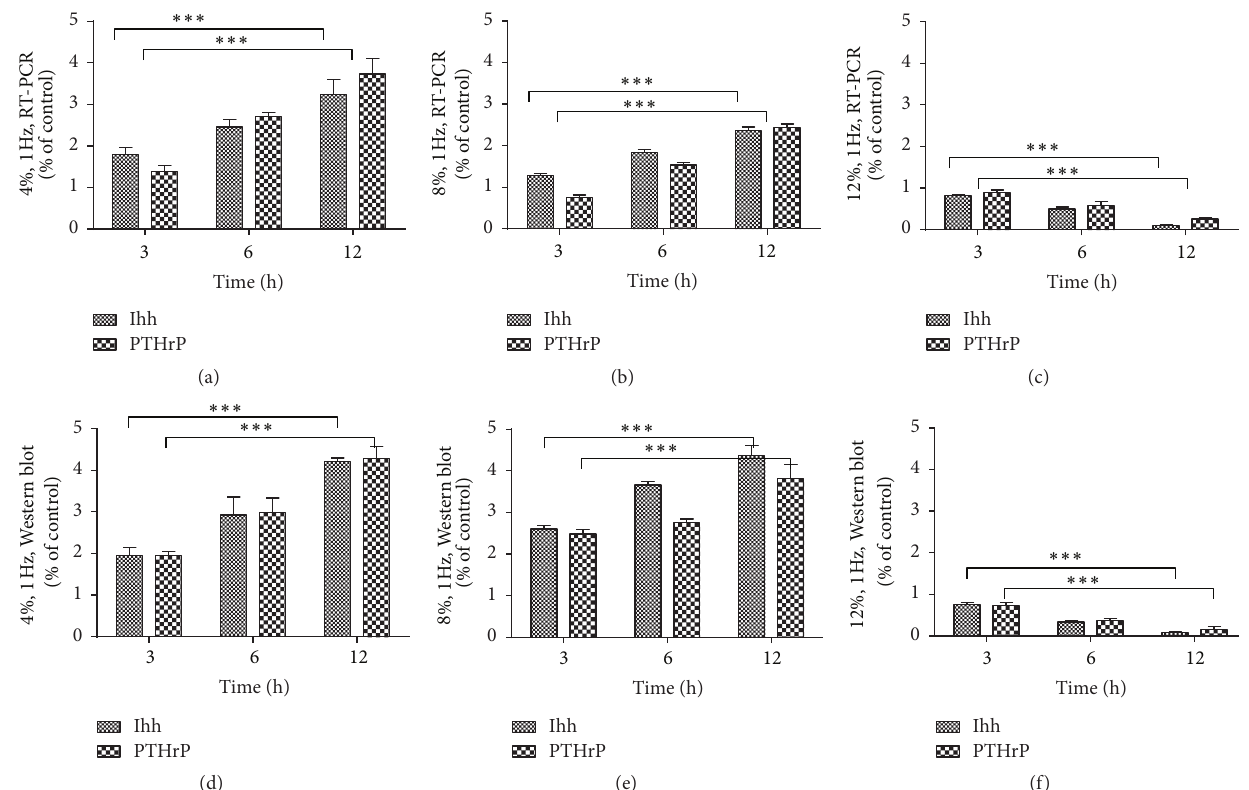
Figure 3: Ihh and PTHrP collagen mRNA expression under 4% (a), 8% (b), and 12% (c) CTS load for 3, 6, and 12h. Ihh and PTHrP protein expression under 4% (d), 8% (e), and 12% (f) CTS load for 3, 6, and 12 h. Values are presented relative to the negative control group (without CTS, value of 1). All data were normalized to the control group ( 𝑛 = 3 , ∗∗∗ 𝑃 < 0.001 , NS: